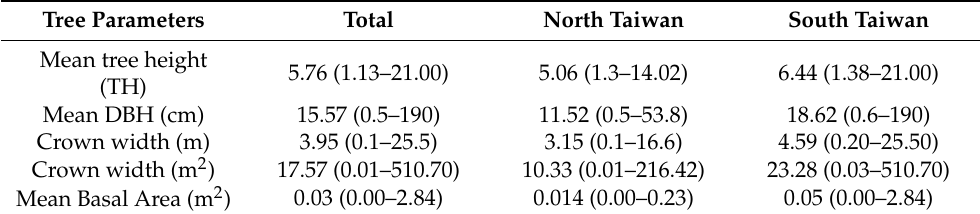
Table 3. Tree dimensions of survey plots.